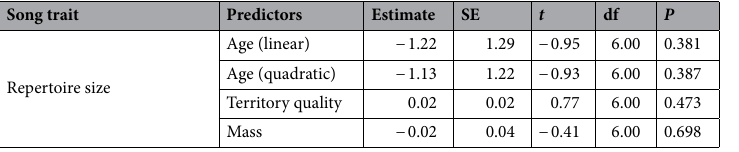
Table 1. Associations of age (showing linear and quadratic contrasts), territory quality, and body mass with song traits in male Seychelles warblers. Significant predictors (P < 0.05) are highlighted in